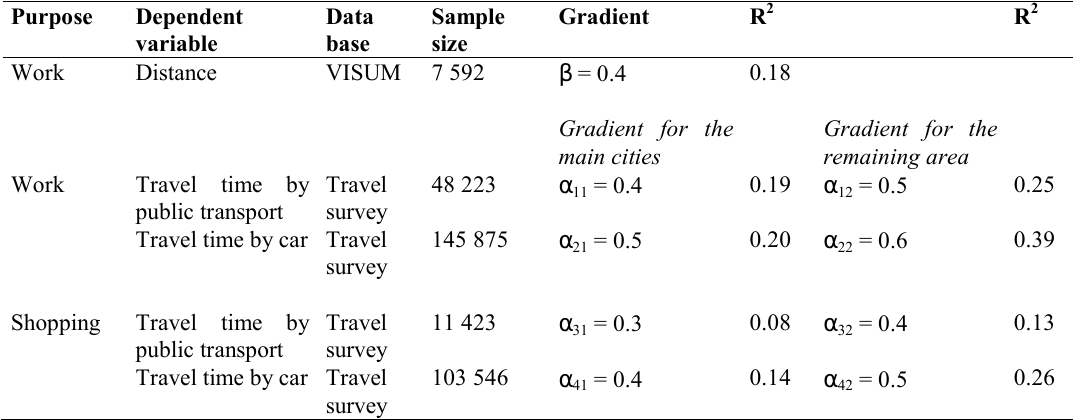
Table 2. The derivation of the different alphas and the beta for the accessibility measures